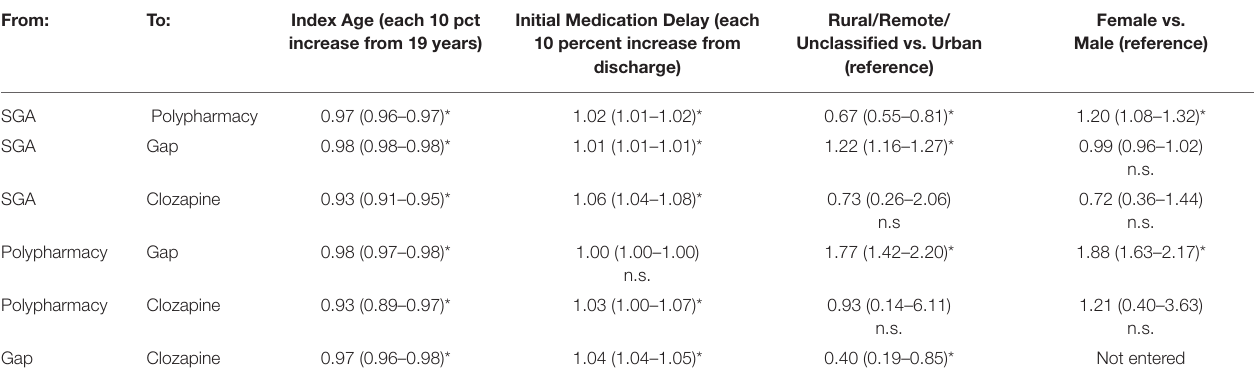
The two left columns represent the outcome, third to sixth columns are predictors that modify the baseline hazard. Predictor variables are entered simultaneously. Asterisk ( * ) indicates significance at p = 0.05.